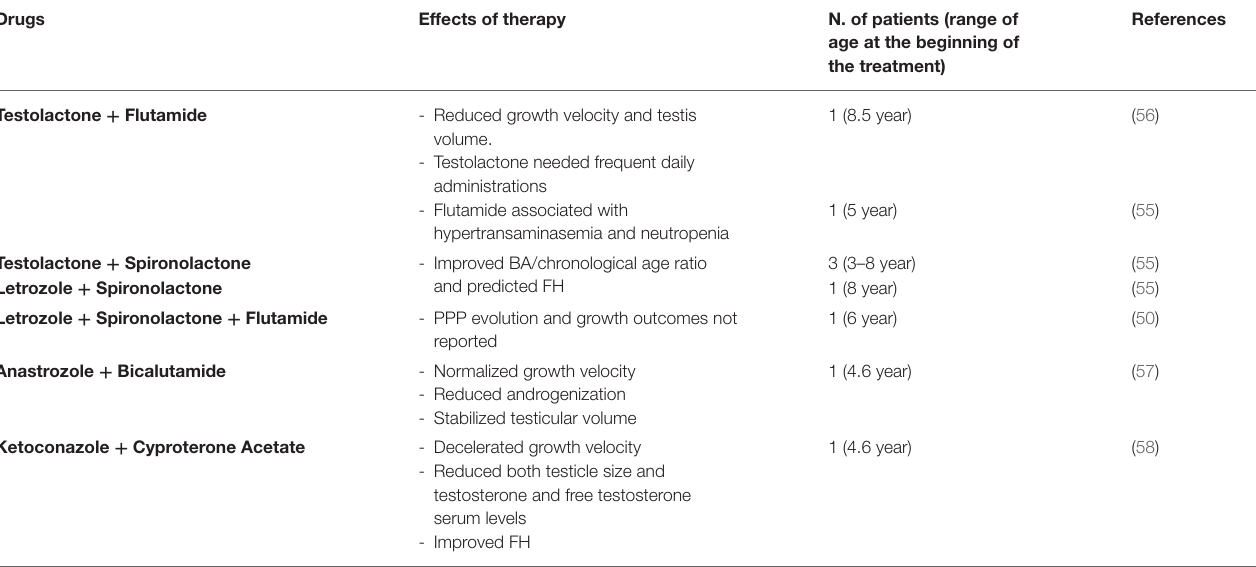
TABLE 2 | Available data on pharmacologic management of PPP in boys with MAS. Drugs Effects of therapy N. of patients (range of